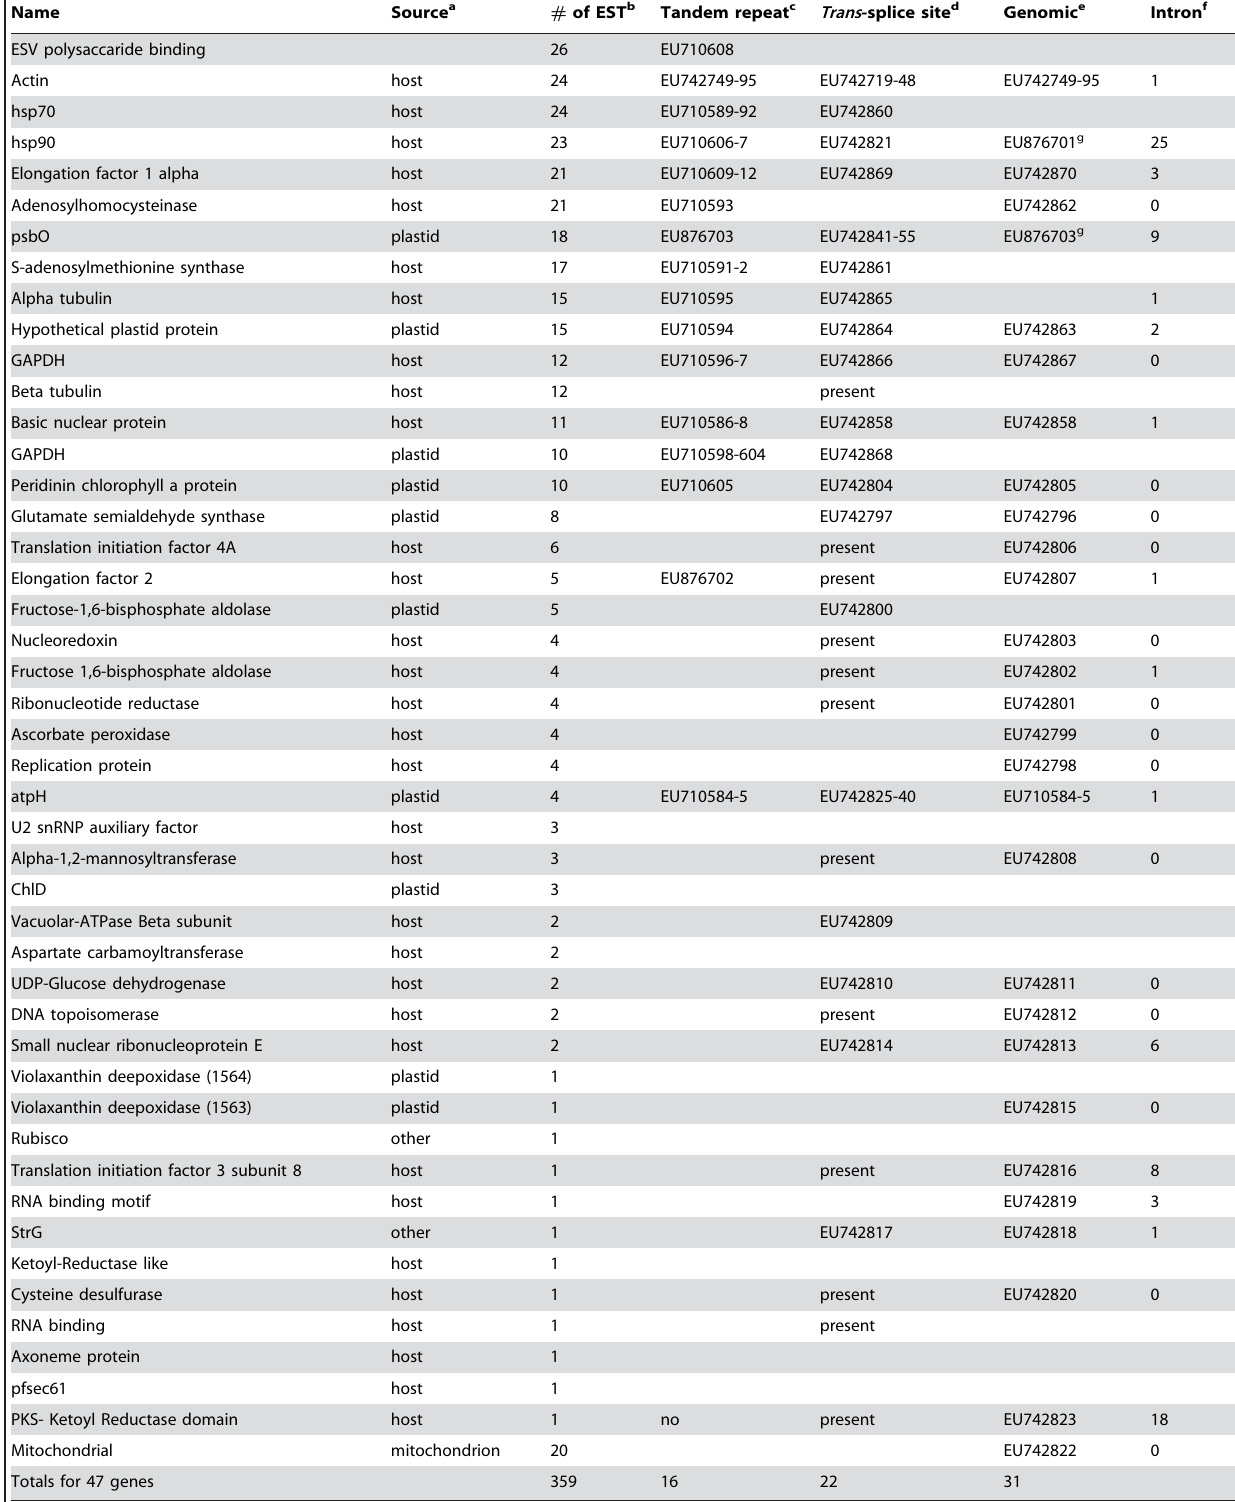
Table 1. Genes selected for this